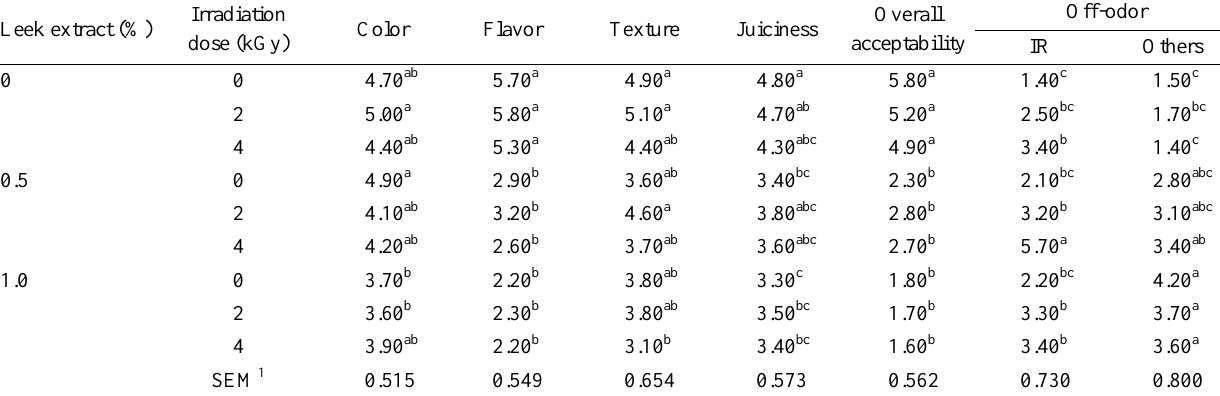
Table 4. Sensory evaluation of the electron beam irradiated pork jerky with added leek extract Leek extract